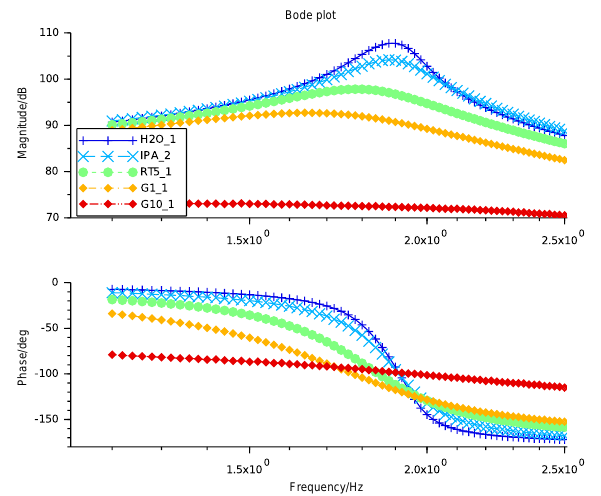
Figure 14. Estimated dissipation factor versus shear viscosity for the liquids listed in Table 1, excluding G10.